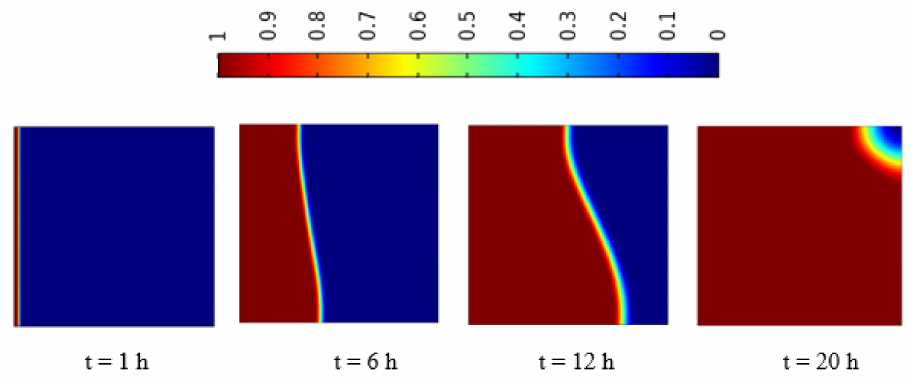
Figure 6. Temporal distribution of liquid fraction during